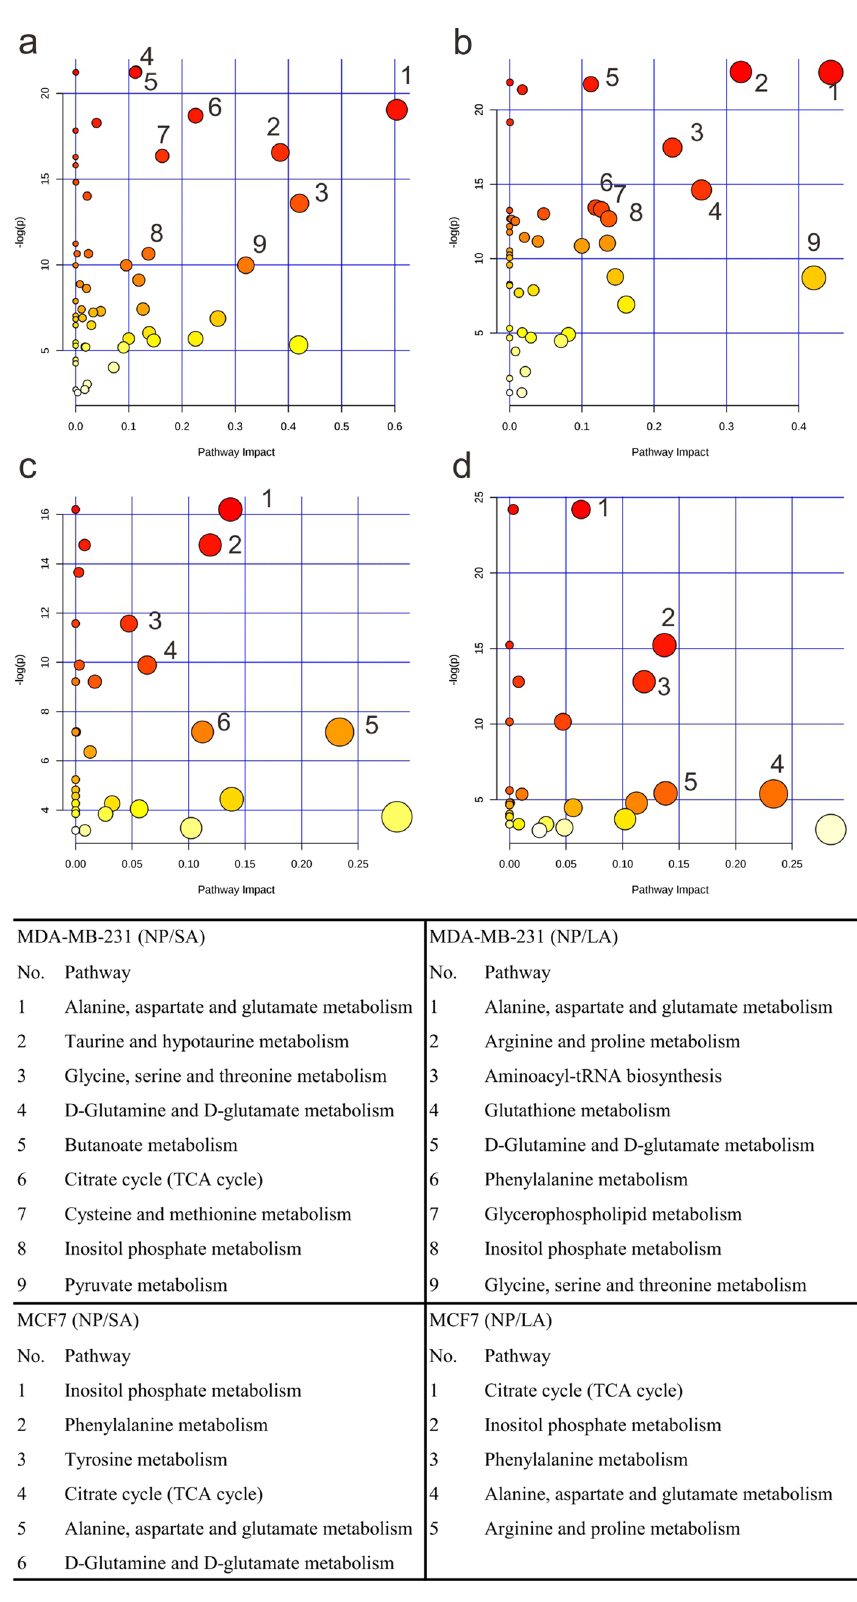
Figure 4. Affected metabolic pathways in MDA-MB-231 ( a , b ) and MCF-7 ( c , d ) cells under acidosis ( a , c ) and lactic acidosis ( b , d